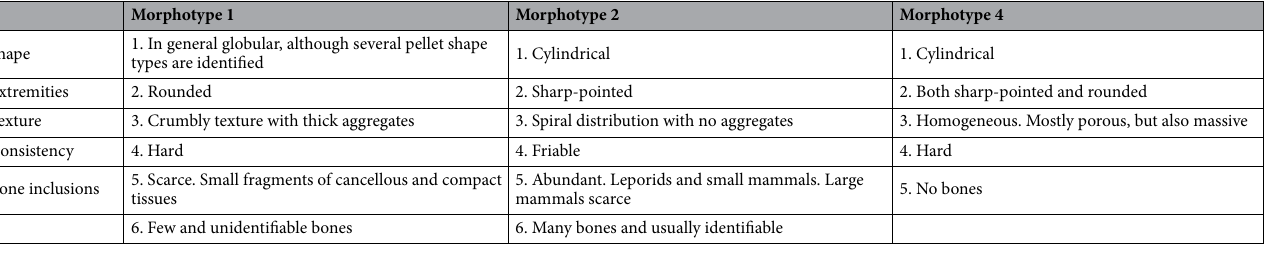
Table 3. Morphotype 1 and morphotype 2 coprolite features, according to Sanz 22 , and the new morphotype